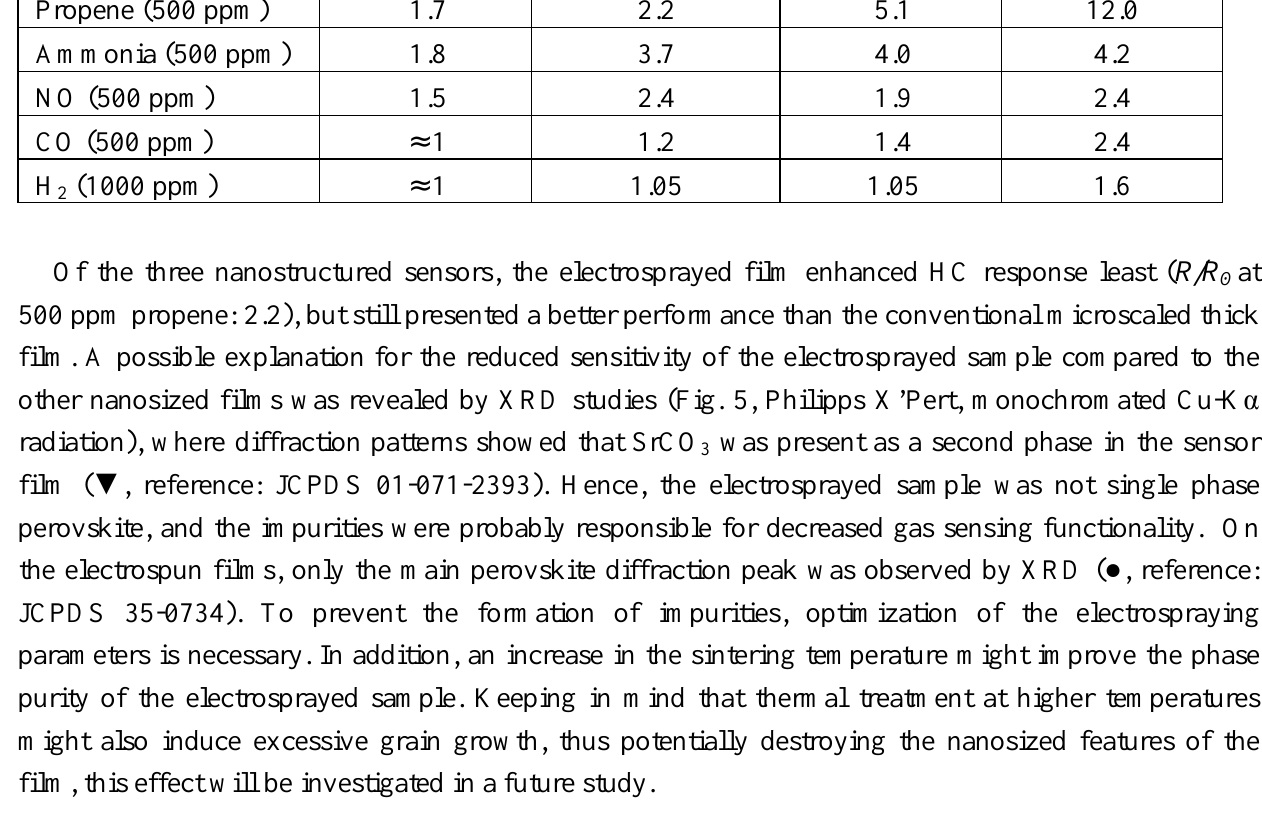
Fe O samples prepared by conventional means and by 0.8 0.2 3- d values towards different analyte gases (concentration as indicated) 0